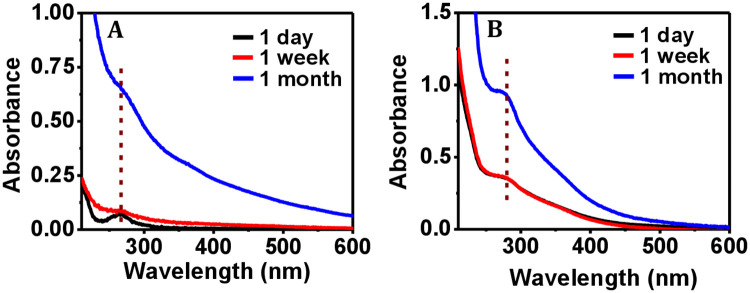
Effect of environmental protease on the UV-visible spectrophotometric data of proteins.Representative UV-Vis spectra of (A) collagen, and (B) ferritin upon exposure to environmental protease for different time intervals. The peak positions are shown by the segmented lines.